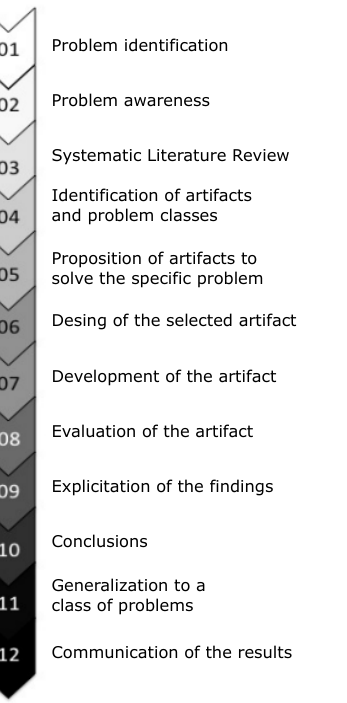
Figure 1. DSR Steps. Adapted from: Leitao et al. (2021).